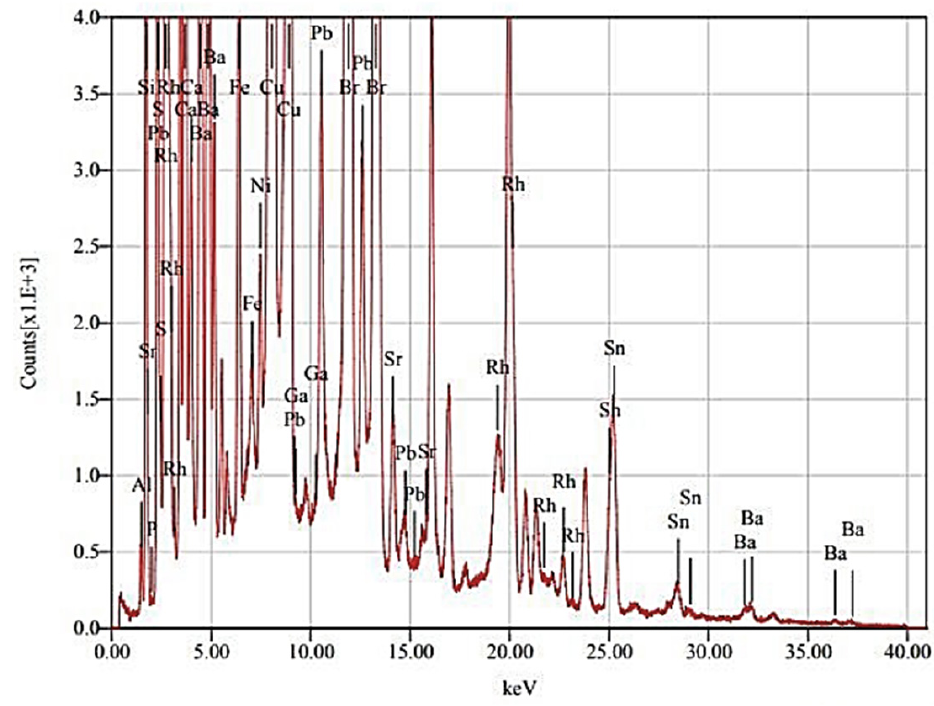
Figure 2. XRF spectra of the M1 fraction.